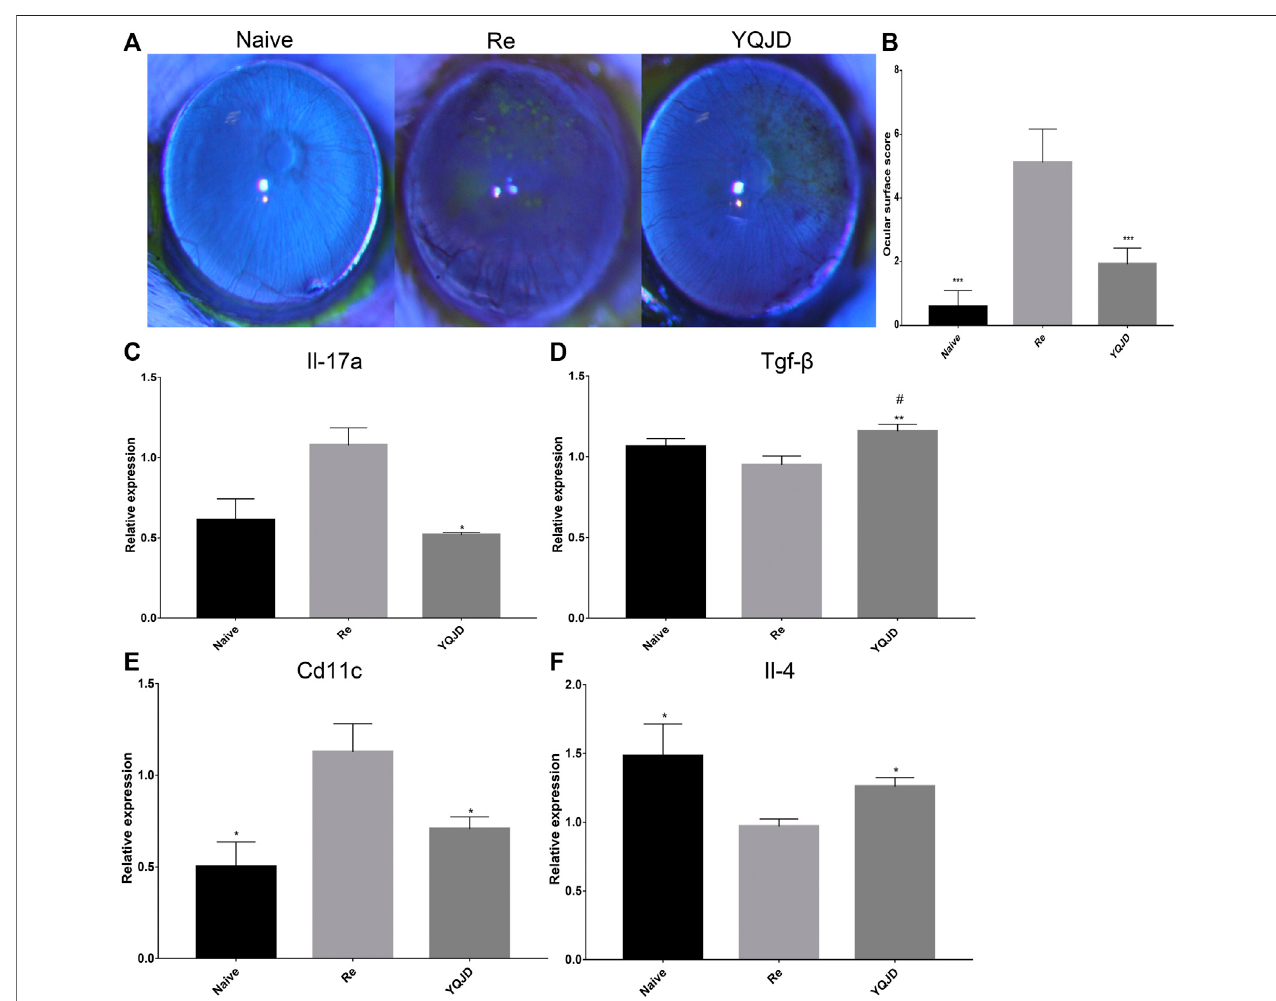
FIGURE1| EffectsofYQJDtreatmentontheocularsurfacescoreandcytokinegeneexpression. (A) Representativeimagesofstainedmiceocularsurfaces3 days after UV irradiation. Sodium fl uorescein staining was carried out as follows: the operator grasped the mouse ’ s ears and neck skin with the thumb and index fi nger of the left hand. The ring fi nger and little fi nger of the left hand were used to clamp the skin on the back and the tail, while the right hand was kept steady and with minimal shaking. The cornea was stained with 10 g/L sodium fl uorescein and examined under a slit lamp microscope. (B) Ocular surface scores of mice 3 days after UV irradiation. (C – F) Expression of (C) Il-17 , (D) Tgf- β , (E) Cd11c , and (F) Il-4 in the mouse cornea. Data are expressed as the mean ± SD. * p < 0.05, ** p < 0.01, and *** p < 0.001 vs. the Re group; # p < 0.05 vs. the Naive group; n (cid:2) 6 for ocular surface scoring; n (cid:2) 3 for RT-qPCR